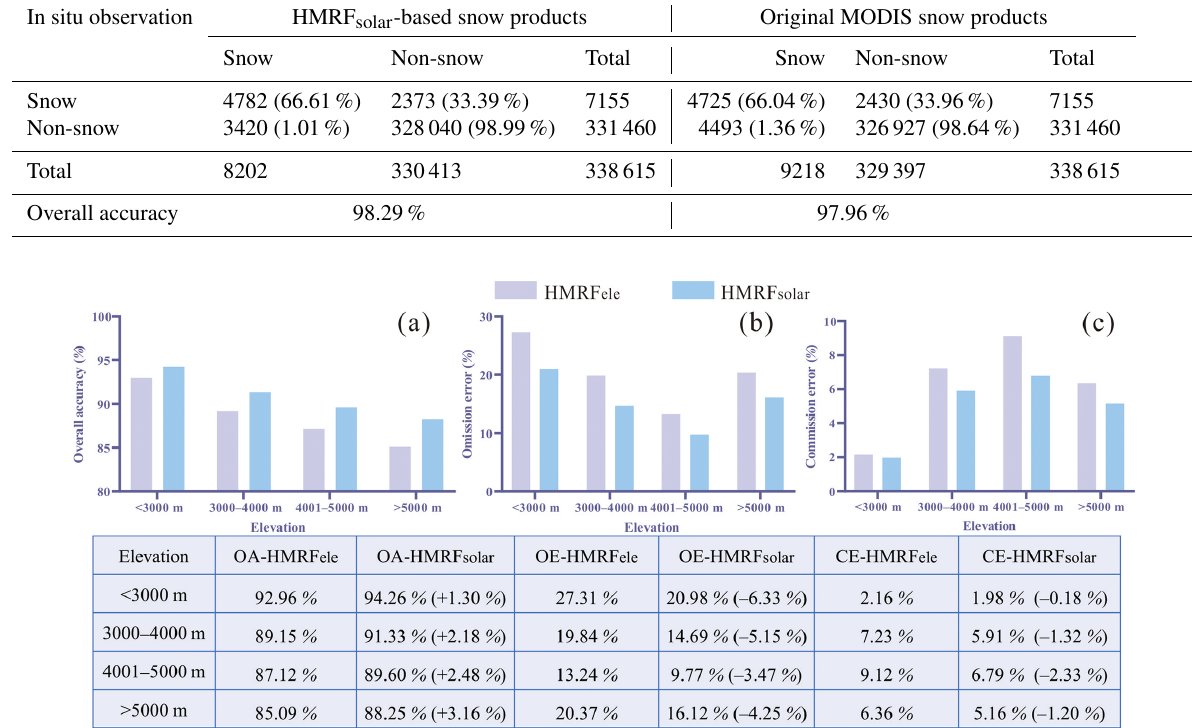
Figure 5. Effect of elevation on OA (a) , OE (b) , and CE (c) of HMRF ele - and HMRF solar -based snow products from